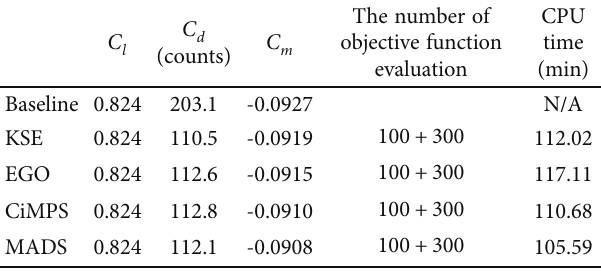
Table 6: The best result comparison of di ff erent methods.